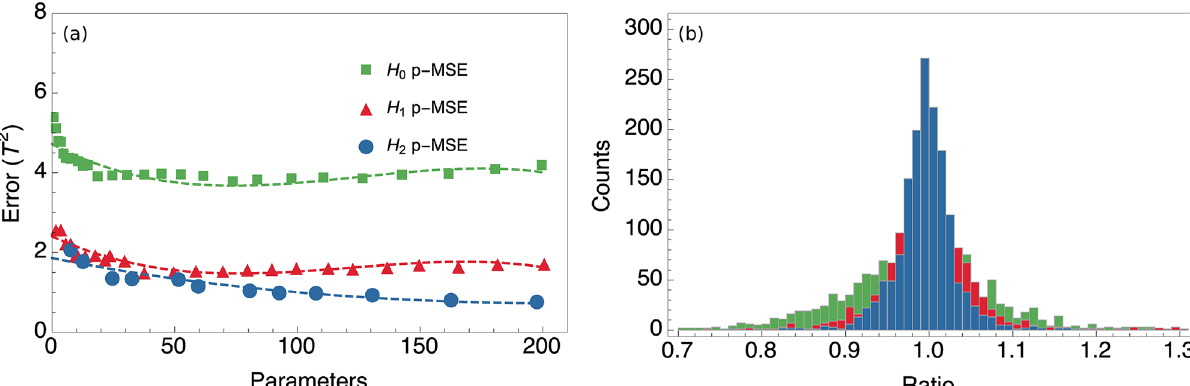
C · B C i i as obtained from direct ab initio calculations C B ′ C / B ′ C i , where i is obtained from the parameterised i C i . The color scheme in ( b ) is the same as in ( a ) for the different